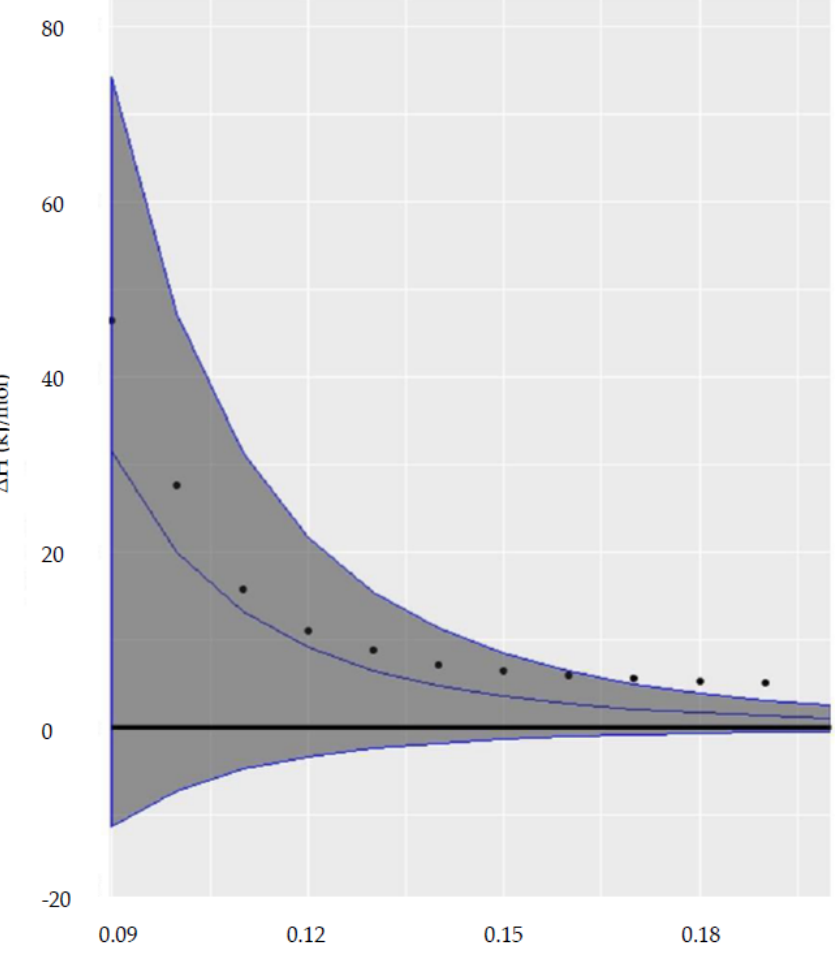
Figure 4. Heat of sorption of fresh feces versus moisture content; calculated with the GAB equation. The relationship between heat of sorption and equilibrium moisture content (x) was fitted as ∆ H = 0.001505(x) − 4.277039 using the nonlinear least squares method in R. Confidence bands on the relationship were generated using an error propagating function.